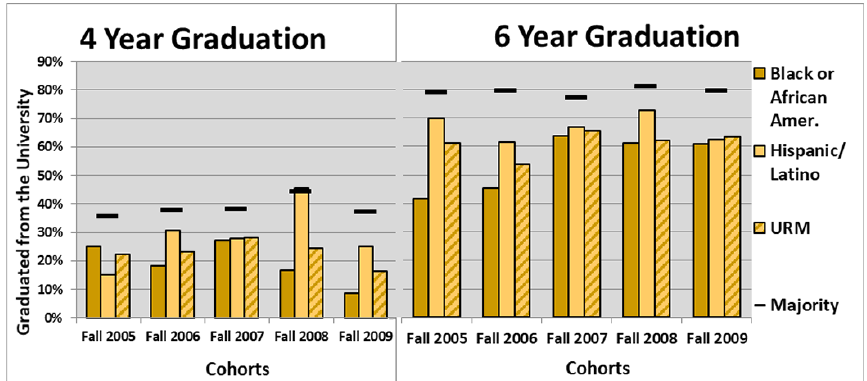
Fig. 3. The 4-year and 6-year graduation rates for residential students at Purdue